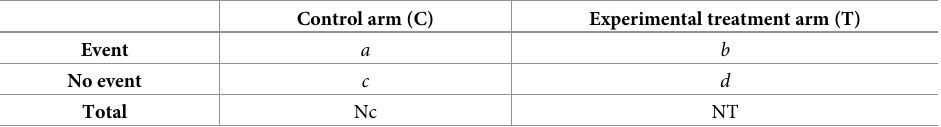
Table 1. Summary data of a completed RCT. a , b , c , d are number of patients in each cell and Nc and NT the total number of patients in the control and the experimental arms